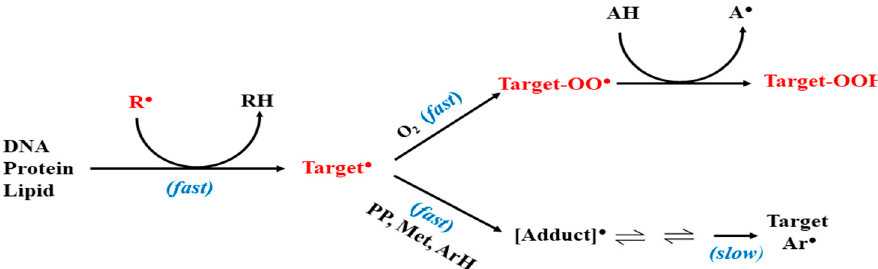
Scheme 2. The major competing reactions of C-centred free radicals under physiological conditions. Intermediates capable of causing molecular damage are in red. PP is a polyphenol, Met an aromatic metabolite and ArH an aromatic molecule